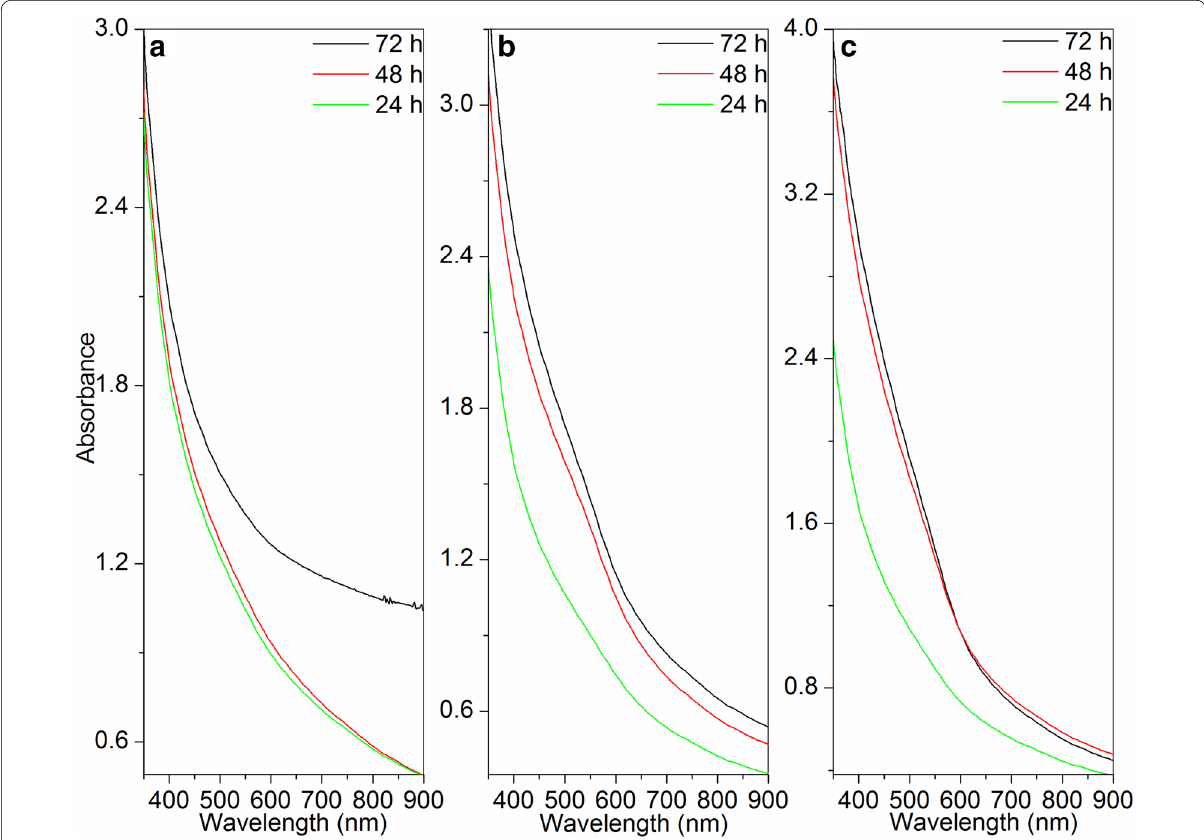
Fig. 4 Time-dependent UV–Vis absorption spectra of selenium nanoparticles synthesized by strain AJK3 at various selenite concentrations: a 0.25 mM, b 0.5 mM, and c 1.0